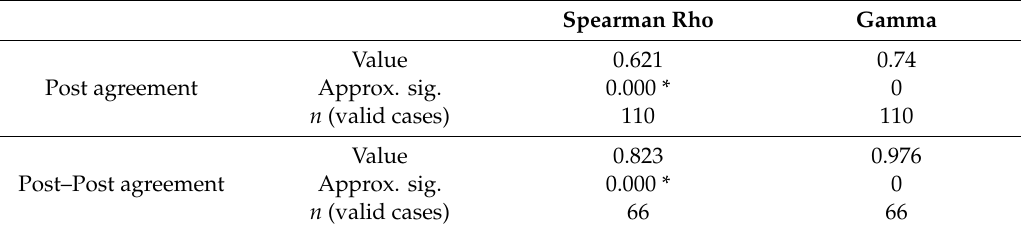
Table 10. Linear association measures: agreement between reviewers and technical skills.